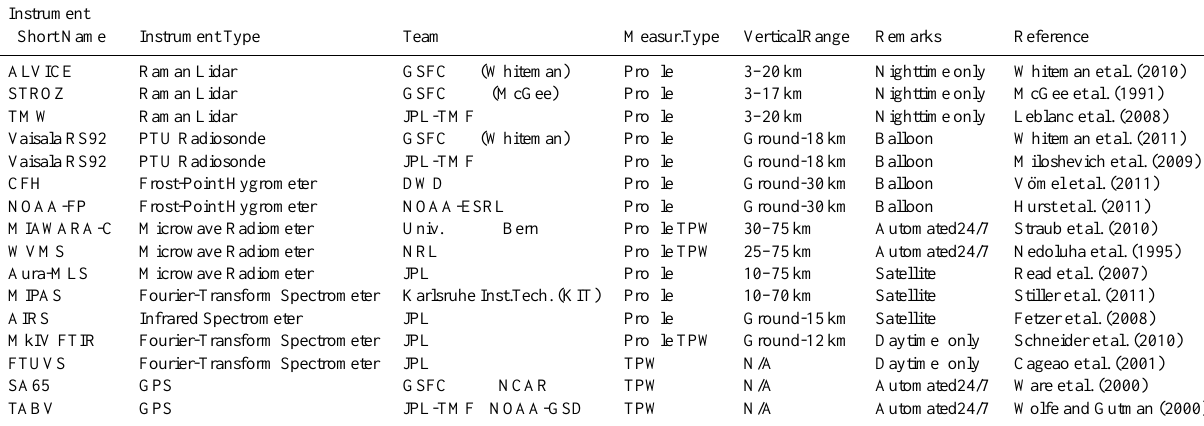
Table 1. Overview of the participating MOHAVE-2009 water vapor